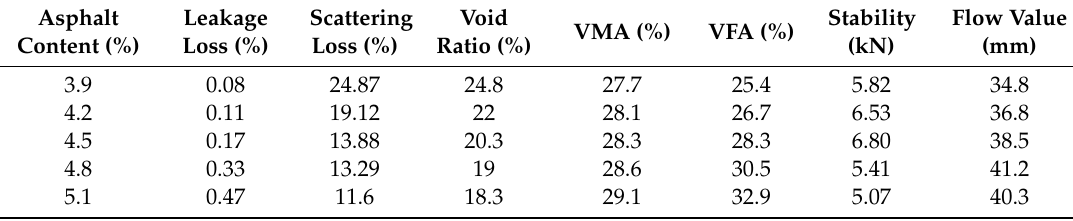
Table A5. The volume parameters of